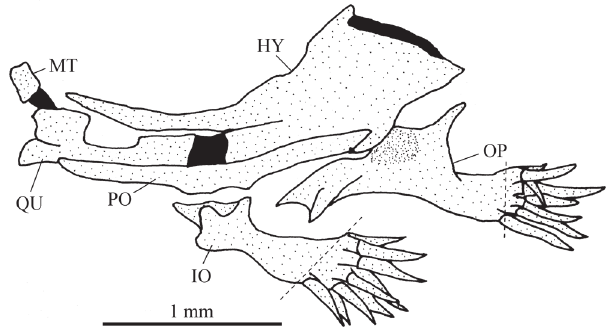
Fig. 3. Suspensorium and opercular apparatus of Listrura camposi , MNRJ 37023, 35.7 mm SL, left side: lateral view. Dashed lines indicate the inclination of the opercular and interopercular paths of odontodes. Legends: HY - hyomandibula, IO - interopercle, MT - metapterygoid, OP - opercle, PO - preopercle, QU - quadrate.